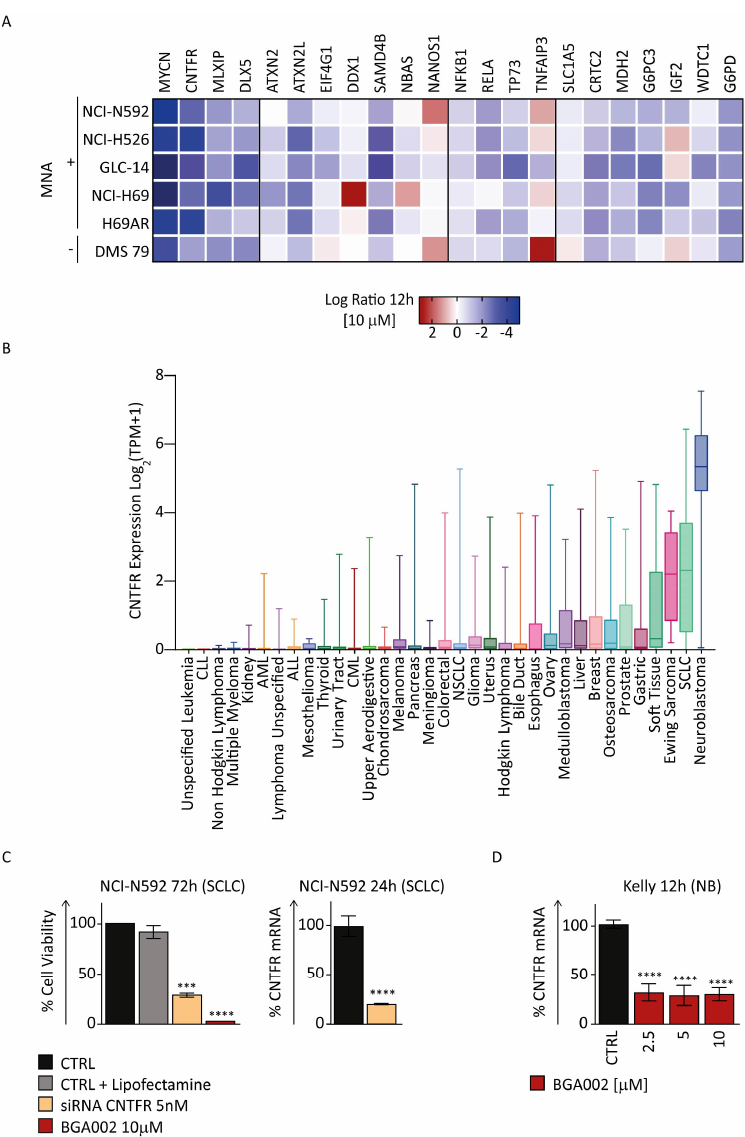
Figure 4. BGA002 regulates the expression of genes involved in cancer progression in SCLC cell lines. ( A ) Heat map of cancer-related gene expression variation after 12 h of BGA002 treatment (10 µ M). ( B ) CNTFR expression in tumor cell lines as reported in CCLE. SCLC cell lines show the second higher value of CNTFR expression among the other tumor type. ( C ) Cell viability assay after treatment with BGA002 or CNTFR siRNA in NCI − N592 cell line. Gene expression inhibition in NCI − N592 cell line after treatment with the same CNTFR siRNA used for viability assessment. ( D ) CNTFR expression inhibition after treatment with BGA002 for 12 h at different concentrations of the MNA − NB cell line. The bars represent the mean, and the whiskers are the standard deviation. Data are analyzed with a two-tailed Student’s t -test: ***, p ≤ 0.001; ****, p ≤ 0.0001; where not indicated p − value >